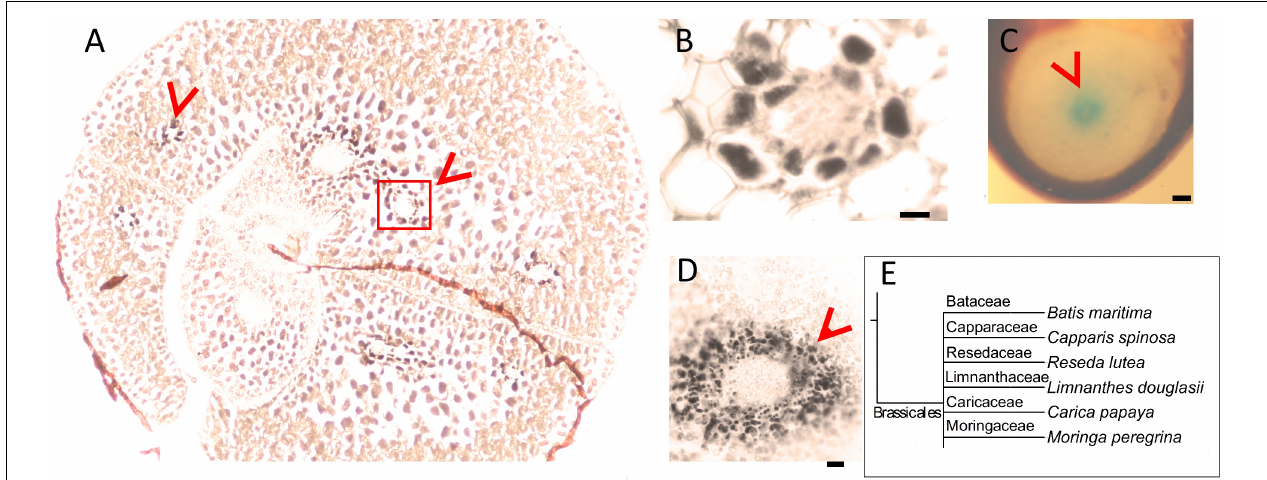
FIGURE 2 | Fe-enriched endodermis is conserved in Brassicales order. Seed cross sections were stained either with Perls or with Perls/DAB and observed under light microscope. (A) Limnanthes douglasii . (B) Higher magnification of the red square in panel (A) . (C) Hypocotyl of Capparis spinosa . (D) Hypocotyl of Batis maritima . (B–D) Focusses on vascular tissues. Fe staining appeared black in panels (A,B,D) and blue in panel (C) . Brown colored structure partially surrounding the embryo in panel (A) is the seed coat. This was already brown before the staining; thus, the color does not reflect the stained Fe. This branch shows species that were examined for Fe reserves in Brassicaceae family and used as a visual aid. Bar is 0.1 mm for panel (A,C) ; 0.01 mm for panel (B,D) . (E) Branch of the taxonomic tree, for the whole tree refer to Figure 8 . This branch shows species that were examined for Fe reserves in the same order but different families and used as a visual aid. Red arrow heads point to examples of specific Fe accumulation pattern, closed rings around provasculature of cotyledons (A,B) and hypocotyl (C,D)